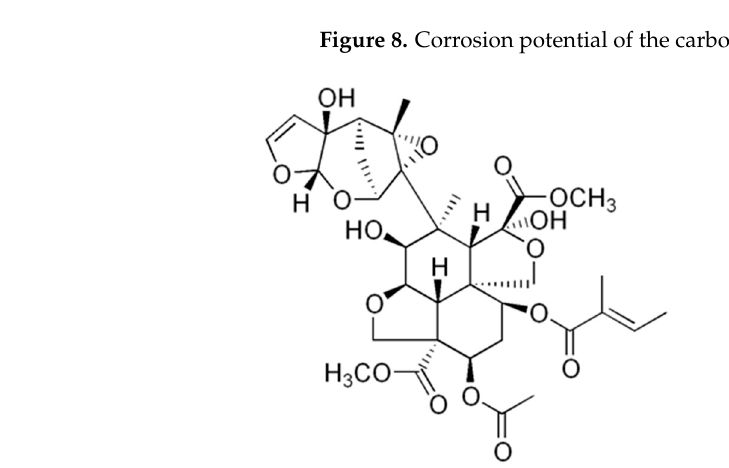
Figure 9. Azidarachtine molecule structure.